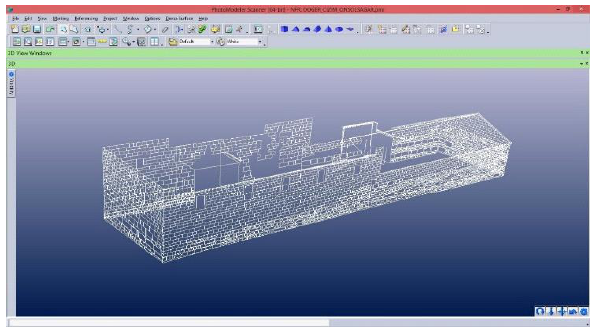
Figure 3. Drawing of